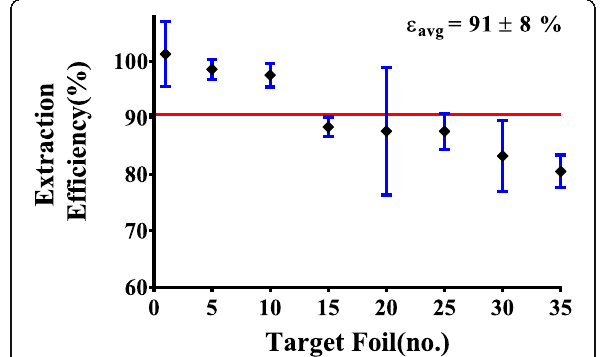
Fig. 3 The average extraction efficiency ( n = 3) expressed as the ratio of radioactivity measured in the extracted Ti disc versus the irradiated Ti foil. The interpolated average efficiency through the target foil stack (red trace). The beam was first incident upon target foil 1